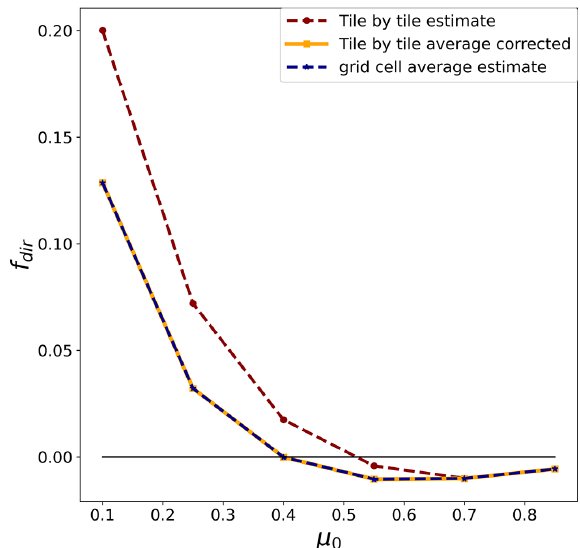
Figure 17. Comparison between grid average estimates of f dir ob- tained by averaging the tile-by-tile corrections and by applying the predictive model for f dir to the grid-cell-average terrain parameter predictors. Results are shown for the eastern Alps site for µ 0 vary- ing from 0.1 to 0.85 and solar azimuth φ = π/